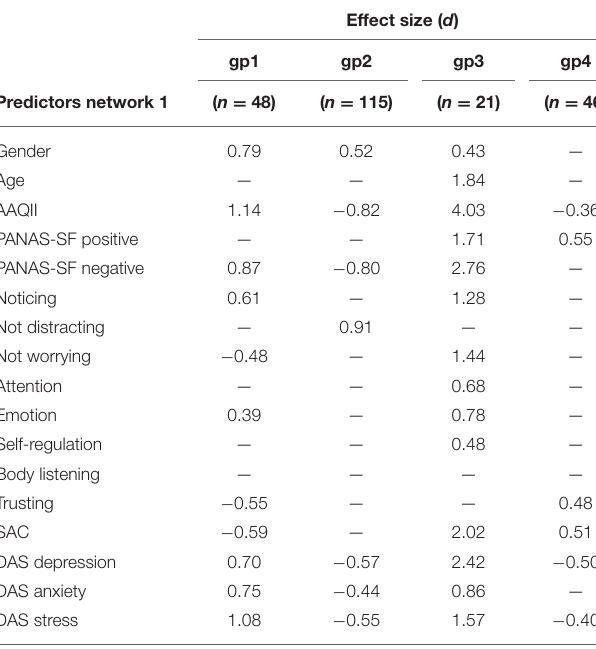
TABLE 8 | Network 1, including DDF, DIF, EOT outcomes. TABLE 9 | Network 2, including just the DDF outcome.